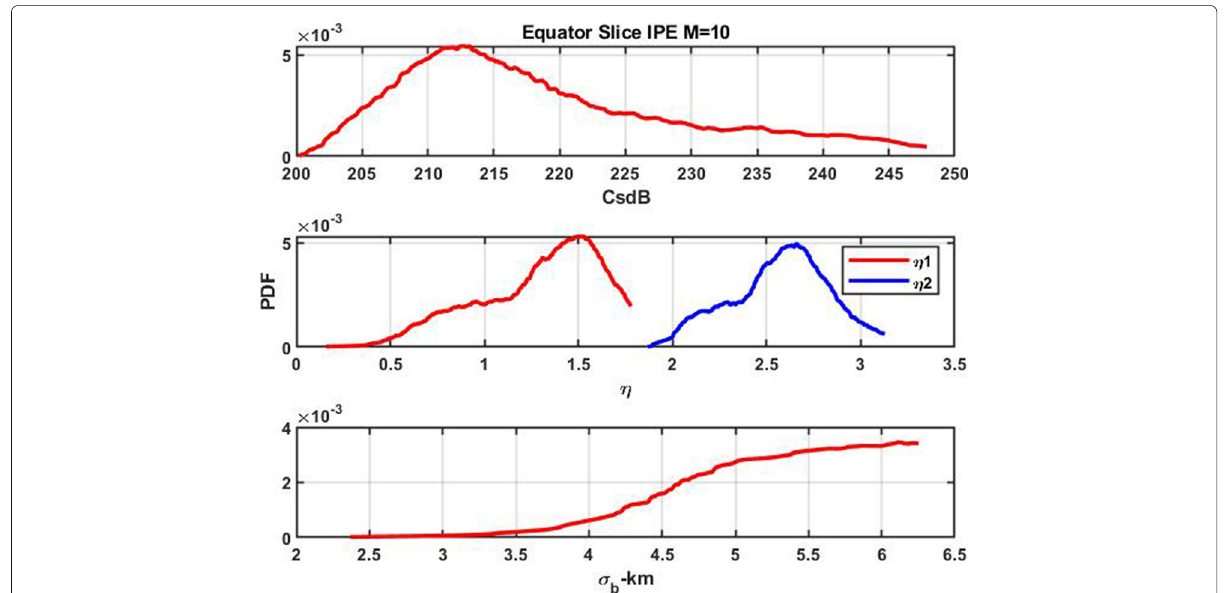
Fig. 16 Probability distributions of equatorial plane stochastic structure computed with M =